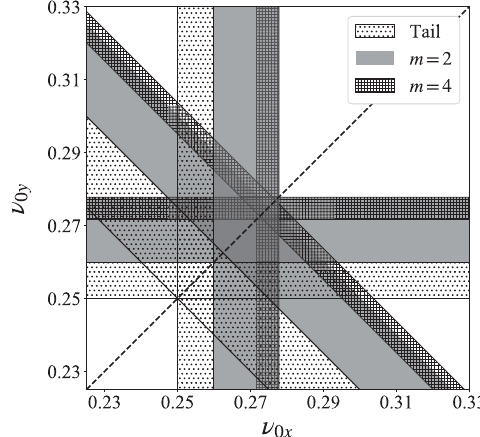
FIG. 2. Stop-band diagram near the cell tune of 0.25 (the betatron phase advance of 90°) under the condition ε x ¼ ε y . The rms tune depression is assumed to be 0.9 everywhere in the